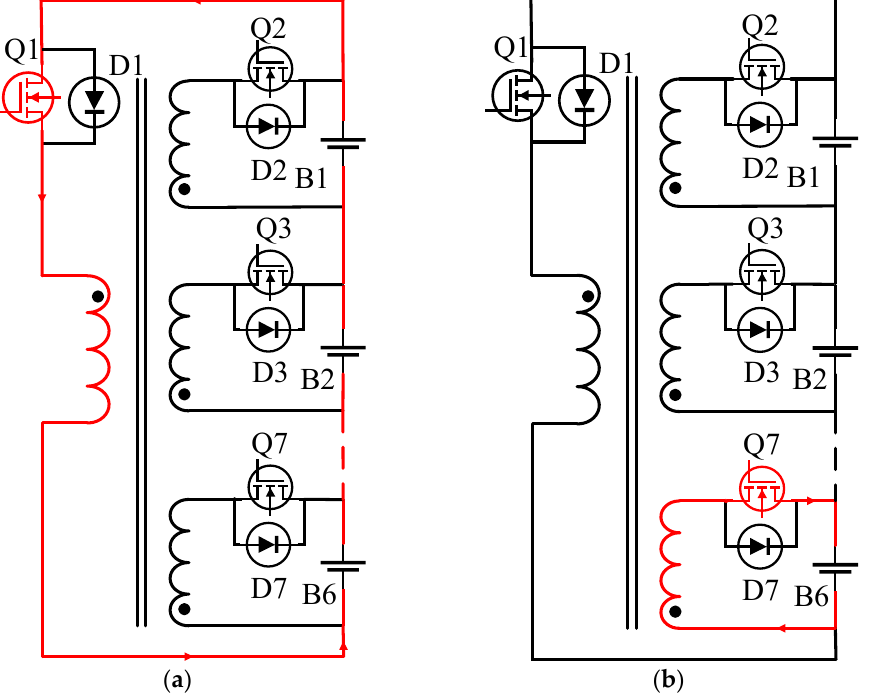
Figure 2. “Valley filling” equalization process. ( a ) “Valley filling” equalization process I. ( b ) “Valley filling“ equalization process II.